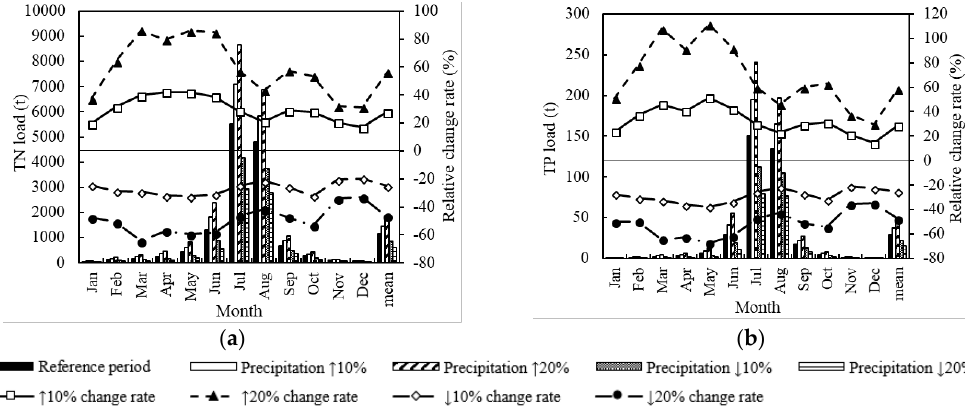
Figure 7. Monthly TN load change ( a ) and TP load change ( b ) under the Precipitation Change scenario.